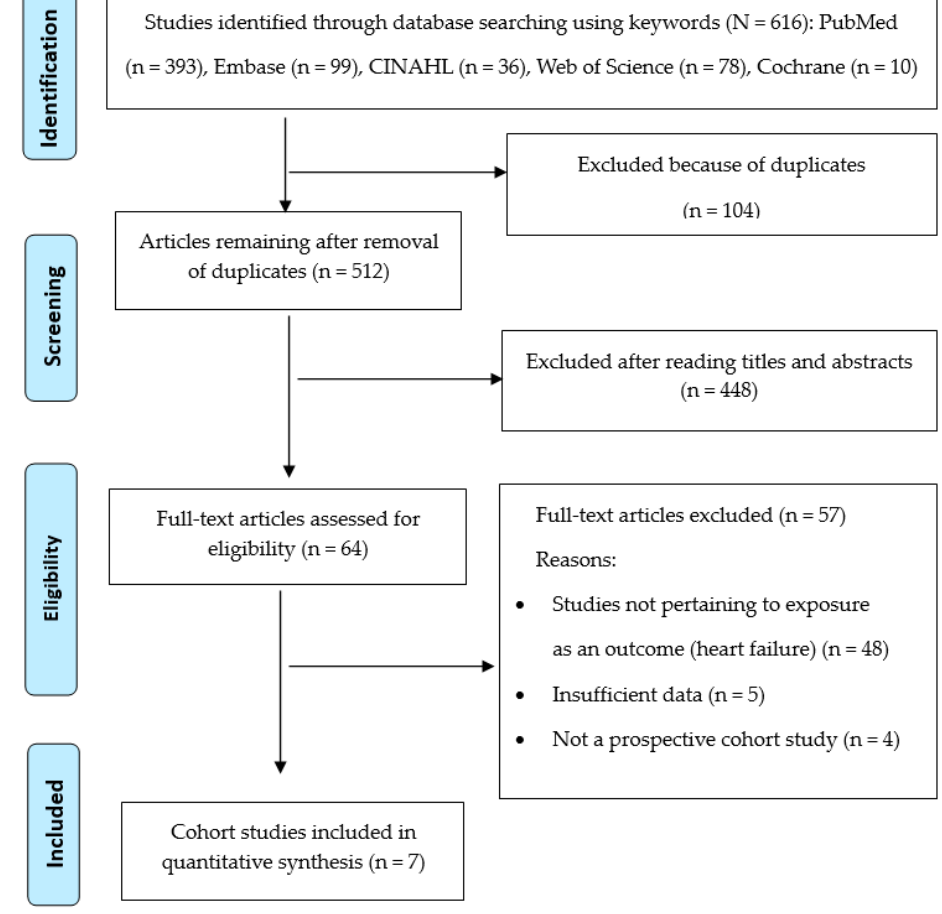
Figure 1. Flowchart of systematic review of literature selection process for the present study.